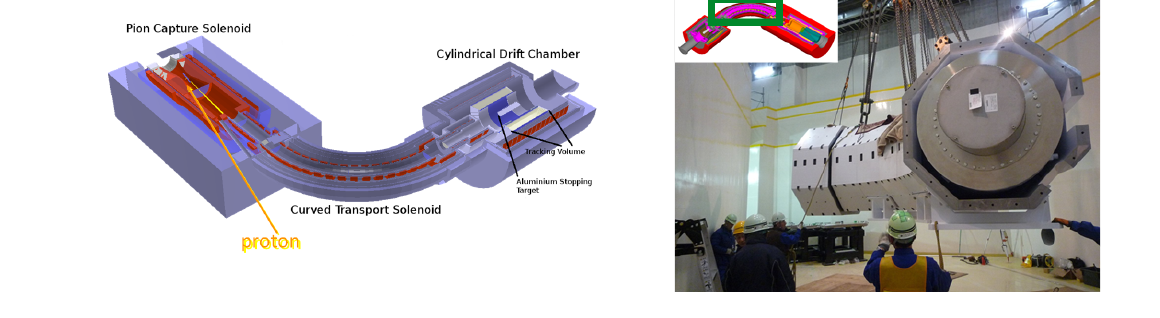
Figure 7: Experimental apparatus of the COMET in Phase-I at the Hadron Hall.